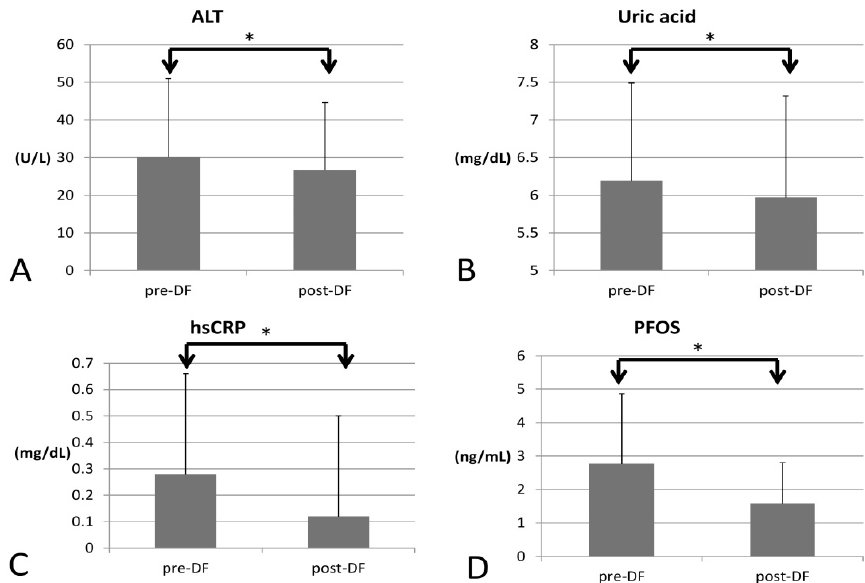
Figure 3. Changes in inflammatory marker, PFOS, uric acid, and liver function before and after DF (all showed significant decrease). ( A ) alanine transaminase (ALT), ( B ) Uric acid ( C ) hsCRP ( D ) per- fluorooctane sulfonate (PFOS). (* for p < 0.05). As for environmental toxins, PFOS decreased significantly (2.774 to 1.605, p = 0.016) and could be removed by DF. However, PFOA was not significantly decreased (3.704 to 3.717, p = 0.847). Serum creatinine significantly decreased (0.87 to 0.81 p = 0.005), implying better renal function and hence higher estimated glomerular filtration rate (eGFR, 102 to 115 mL/min, p = 0.027). Uric acid (6.19 to 5.97 mg/dL, p = 0.012) and ALT (30 to 26 U/L, p < 0.001) both decreased significantly, which may have resulted from an improvement in renal and liver function after toxins were removed. Over the two-week process, there were no significant changes in AST ( p = 0.729), HbA1c ( p = 0.929), or insulin ( p = 0.933). 3.4. Comparison of DF Effect on DM and Non-DM Patients Table 3 compares patients with and without DM. DM patients were heavier in body weight and had higher hemoglobin (Figure 4), hematocrit, serum glucose, HbA1c, insulin, ALT, and triglycerides, but significantly lower HDL and LDL compared with nondiabetic patients. A similar pattern was found after DF except for TG and T chol/HDL. Table 3. Comparison of DM (n = 11) vs. non-DM (n = 31) patients before and after DF. n = 45 (Mean ± SD)